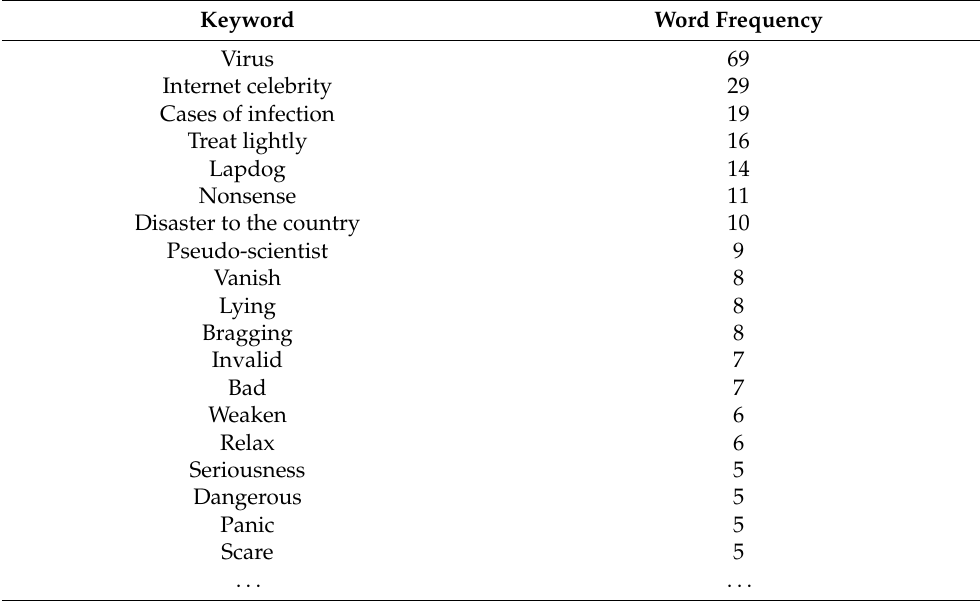
Table 1. Keyword frequency statistics (partial